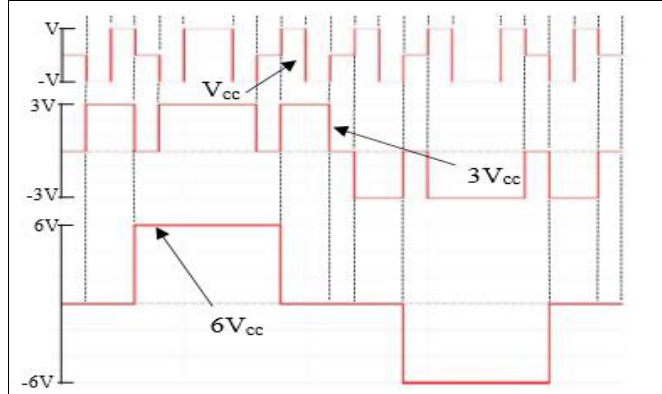
Figure 8: Waveform determined for each H-bridge of the 11-level multilevel